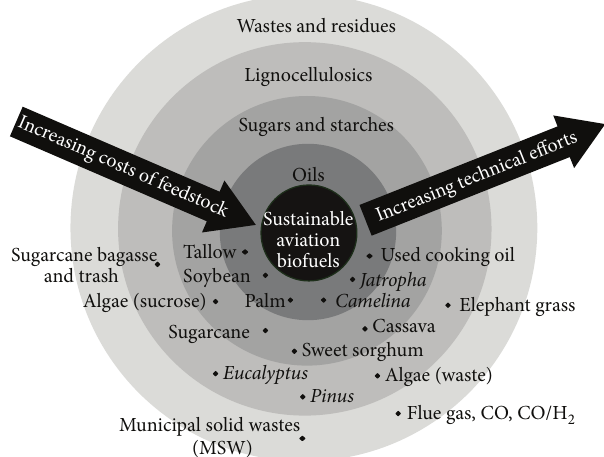
Figure 5: Feedstocks and their relative position according to costs and technical effort to be converted to aviation